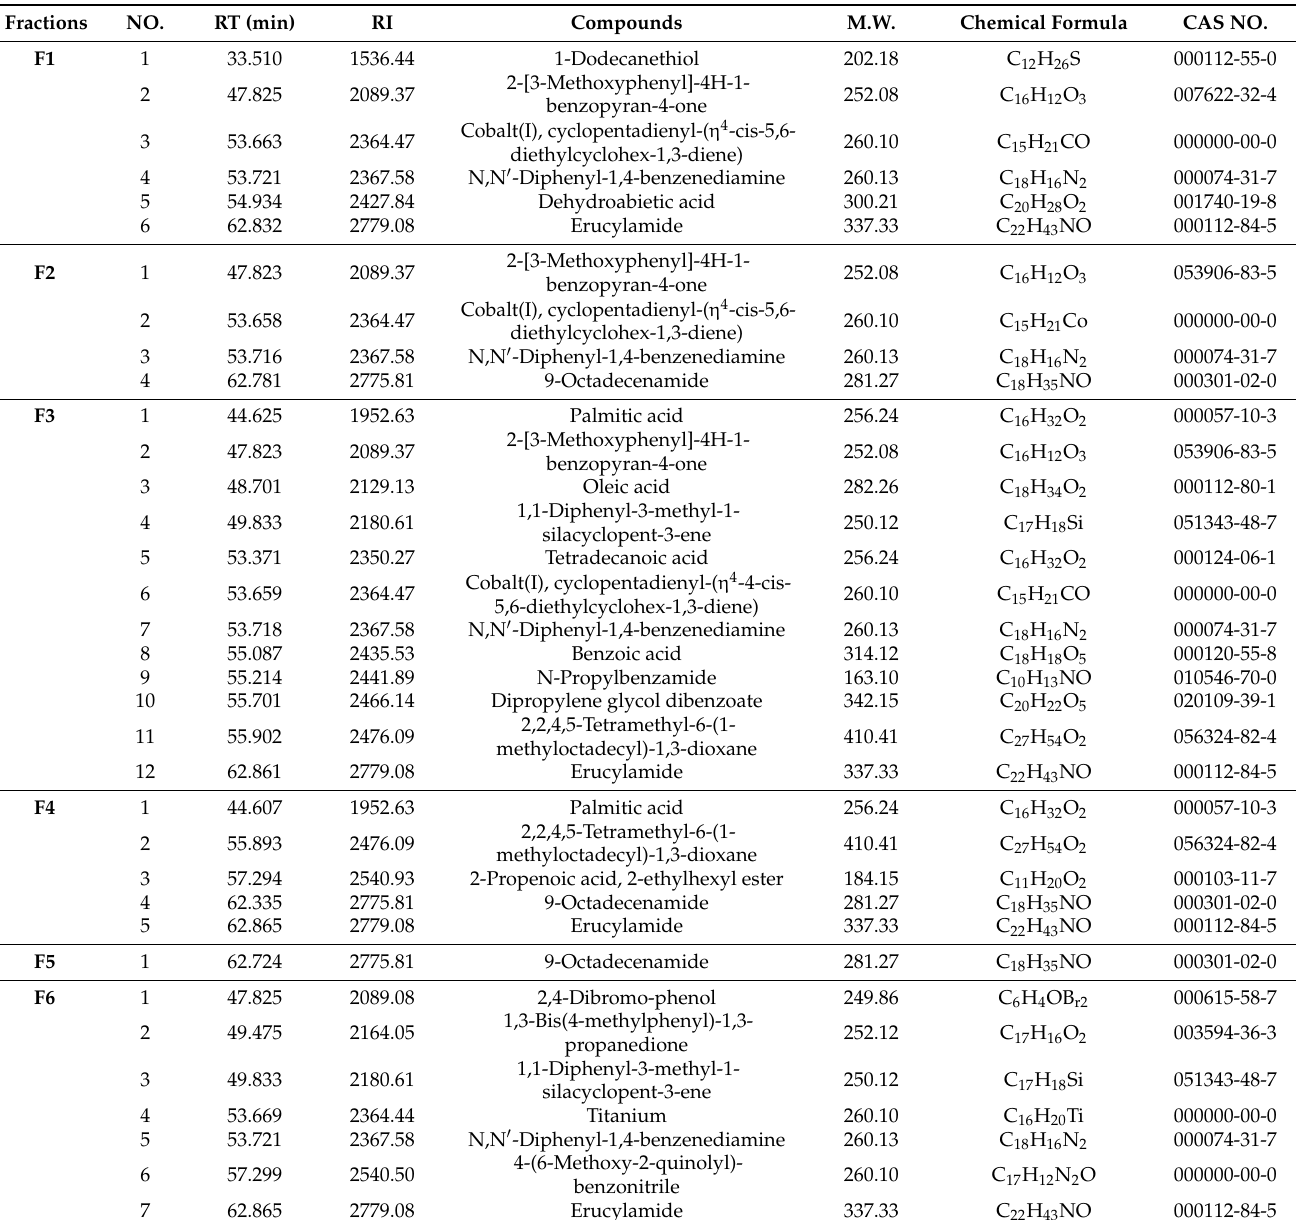
Table 2. Chemical components of ER fractions 1–6 assayed with Gas Chromatography–Mass Spectrometry (GC–MS). Fractions